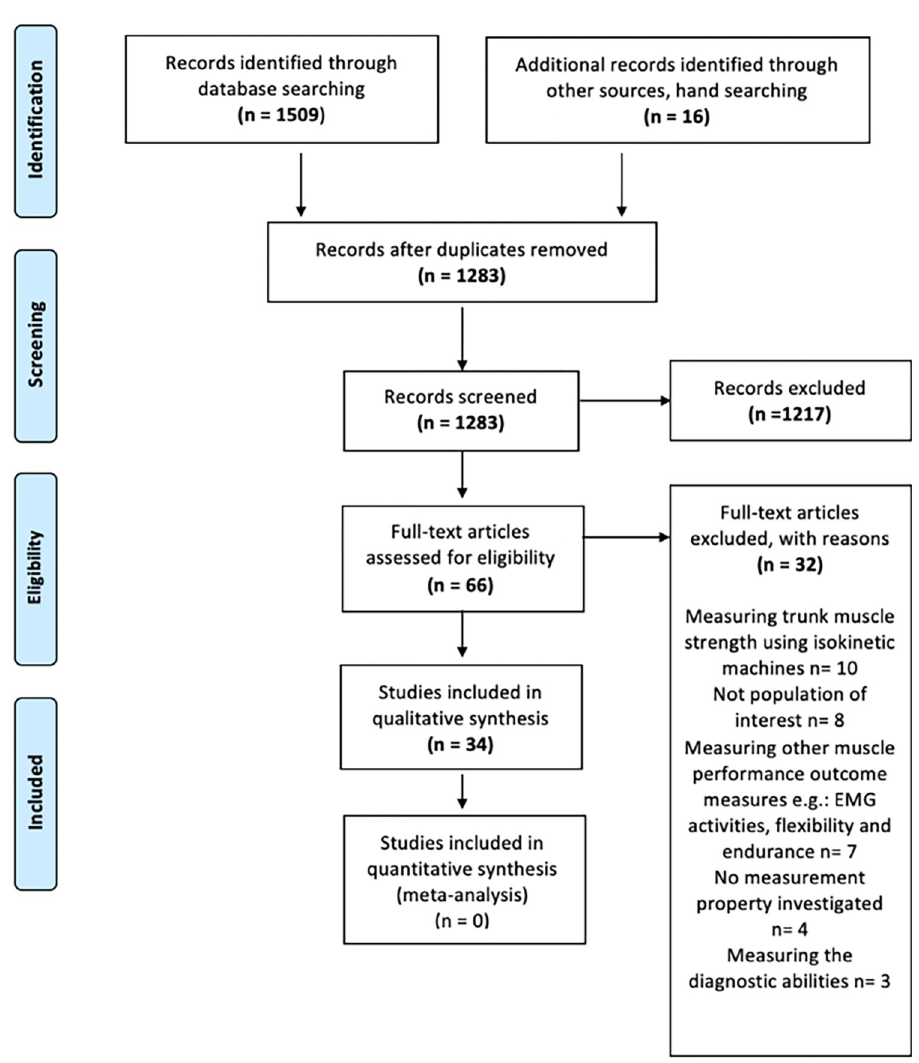
Fig 1. Flow diagram summarising numbers of articles included at each stage of the